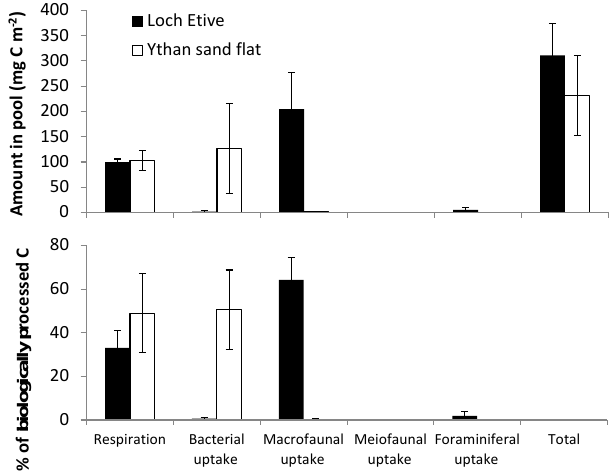
Figure 2. The distribution of initially added C between different biological pools at the end of the experiments in absolute terms (upper panel), and as percentages of total biological C processing (lower panel). Note there are no data for meiofaunal or foraminiferal uptake on the Ythan sand flat.